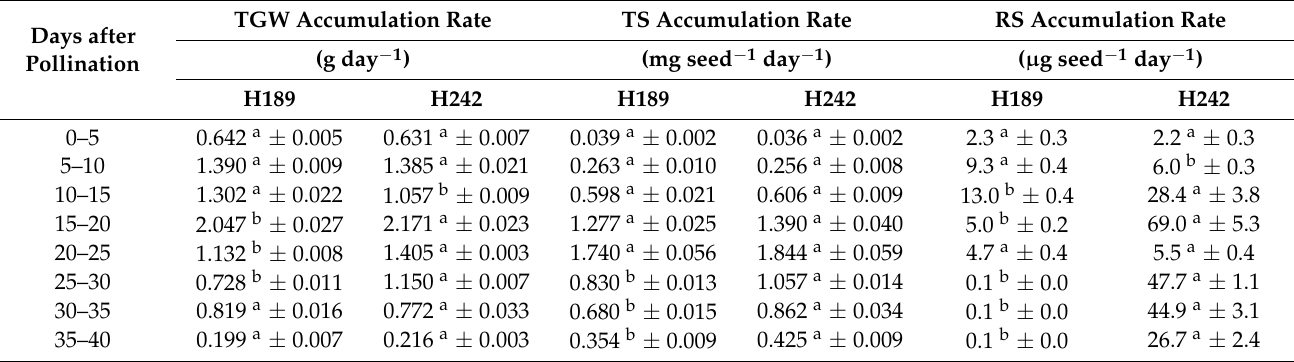
Figure 1. Dynamic changes in the resistant starch content, total starch content and thousand-seed weight during wheat grain filling. All data are the means ± SD of three biological replicates. ( a ) Dynamic changes in the resistant starch content per seed during wheat grain filling. ( b ) Dynamic changes in the total starch content per seed during wheat grain filling. ( c ) Dynamic changes in the thousand-grain weight during wheat grain filling. Table 1. Accumulation rates of the thousand-kernel weight, total starch and resistant starch. All data are the means ± SD of three biological